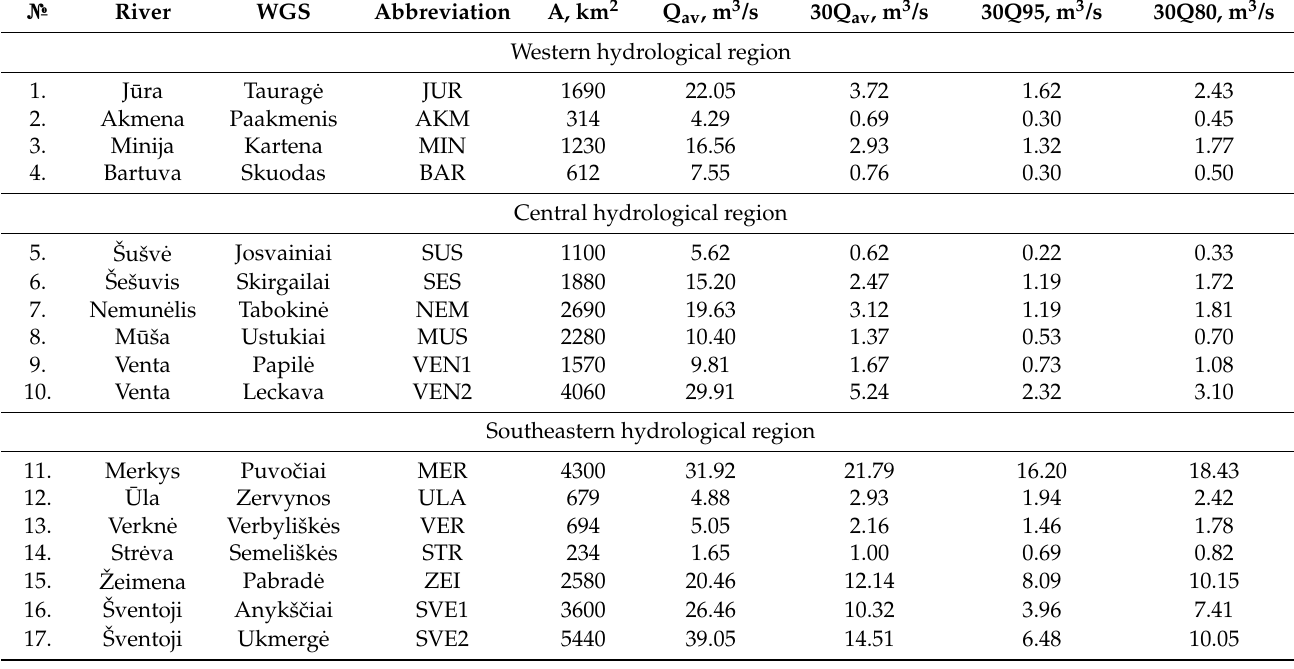
Table 1. Characteristics of selected water gauging stations (1961–2020).